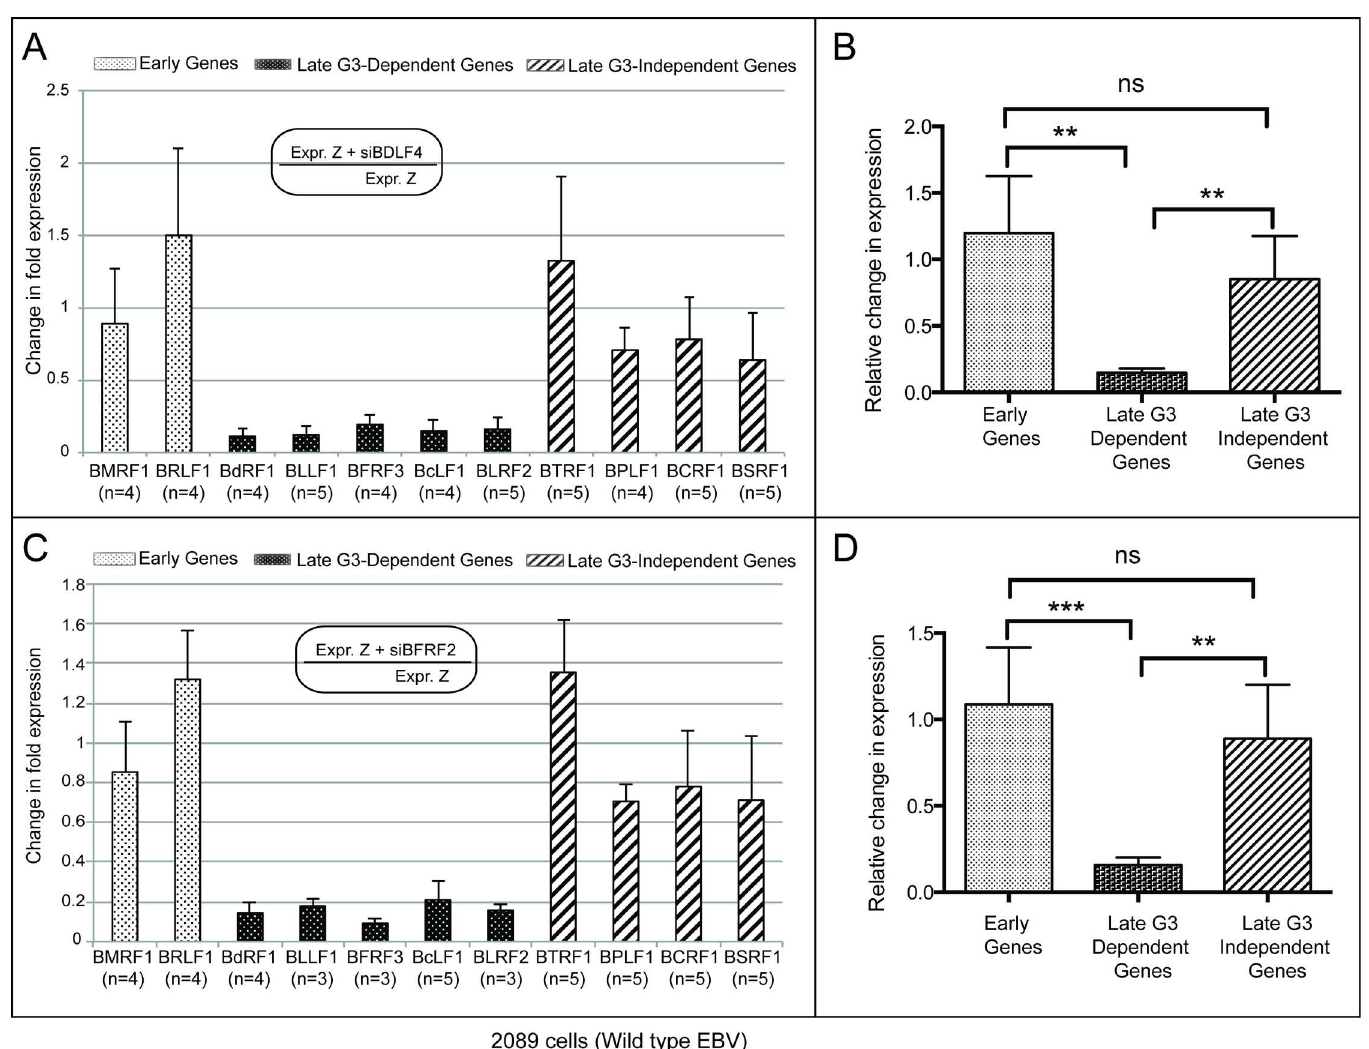
Fig 7. The late gene regulators BDLF4 and BFRF2 are dispensable for expression of BGLF3-independent late genes. The bar graph depicts the effect of silencingexpressionof BDLF4 (panelA) and BFRF2 (panel C) on the level of eleven transcripts that represent early, late BGLF3-dependentand late BGLF3-independentlytic genes. The experiments were performed in 2089 cells transfected with empty vector, ZEBRA or ZEBRA plus the indicatedsiRNA. The cells were harvested48h after transfection. The data were compiledfrom replicateexperiments indicatedfor each transcript by (n). The bar graphs in panels (B) and (D) illustrate combinedchangesin fold expressionamong the three subclassesof lytic genesas a result of transfectingsiBDLF4 or siBFRF2. Asterisks denotestatistically significantdifferences; ns, mark non-statistically significantdifference; G3, BGLF3, and Z,